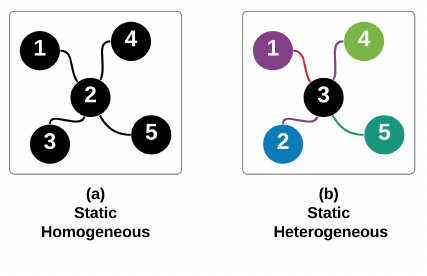
Figure 9. Example of Static Networks and disappear; (3) Positions of nodes changes,